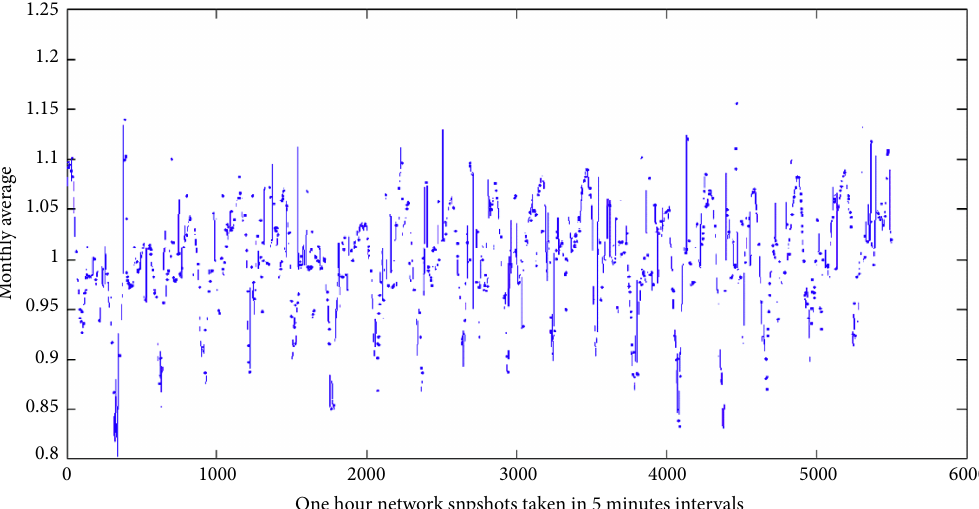
Figure 12: Dynamics of the largest eigenvalue of the rides-dynamic network over time. X -axis denotes the time, given in 5-minute granularity. Y -axis denotes the change of the largest eigenvalue of the network compared to its monthly